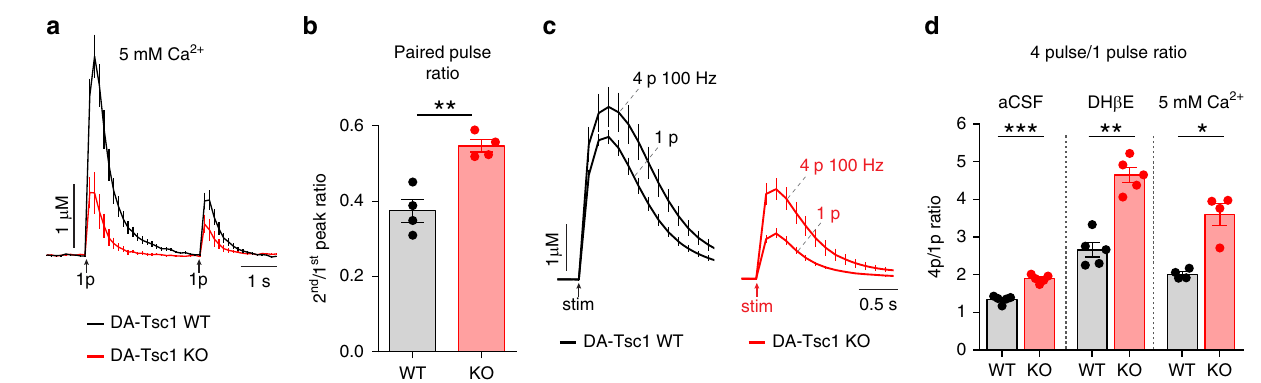
Fig. 4 Loss of Tsc1 reduces striatal DA release probability. a Mean ± SEM dorsolateral striatal [DA] o versus time evoked by single-pulse stimulations (1 p ) delivered 3 s apart in 5 mM extracellular Ca 2 + (1 μ M DH β E applied throughout). Traces are an average of 16 transients per genotype from four mice. b Mean ± SEM ratio of peak [DA] o in the dorsolateral striatum evoked by the second-to- fi rst pulse in 5 mM extracellular Ca 2 + (1 μ M DH β E applied throughout). ** p = 0.0055, paired two-tailed t test. c Mean ± SEM [DA] o versus time evoked by single-pulse (1 p ) or high-frequency stimulation (four pulses at 100 Hz, 4 p ) in the dorsolateral striatum in aCSF. Traces are an average of 18 transients for 1 p and nine transients for 4 p from fi ve mice per genotype. d Mean ± SEM ratio of peak [DA] o evoked by a four-pulse train to single-pulse stimulation in the dorsolateral striatum in aCSF ( n = 5 mice per genotype), 1 μ M DH β E ( n = 5 mice per genotype), or 5 mM extracellular Ca 2 + ( n = 4 mice per genotype). * p = 0.0204; ** p = 0.0024; *** p = 0.0009, paired two-tailed t tests. For all bar graphs, dots represent values for individual mice. See also Supplementary Fig. 2. Source data are provided as a Source Data fi